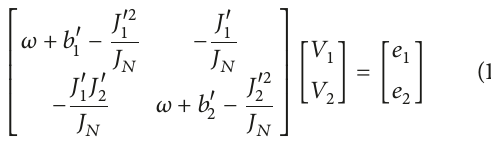
eliminated from (12), by using the last row, we get the new matrix